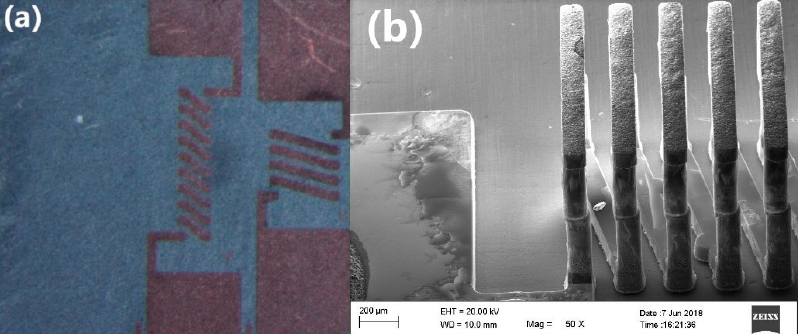
Figure 10. The silicon corn inductor ( a ) photographed by the peripheral microscope and ( b ) a detailed image photographed by a scanning electron microscope (SEM).